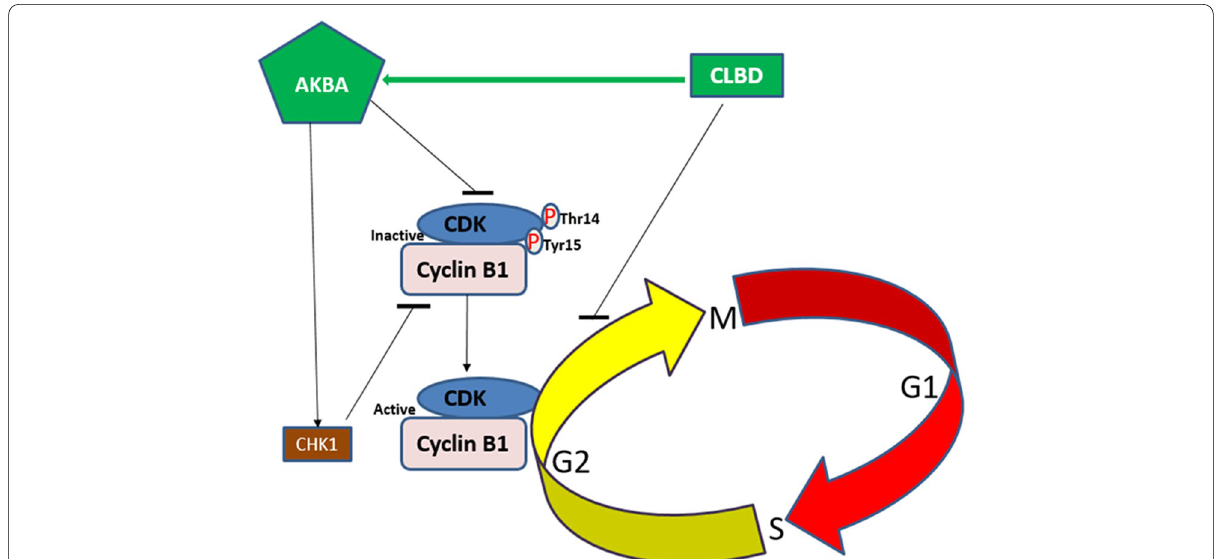
Fig. 6 Blockage of cell cycle progression by chloroform extract and acetyl-11-keto-beta-boswellic acid obtained from Boswellia dalzielii stem bark at G2/M Phase. CLBD (chloroform extract of the Boswellia dalzielii stem